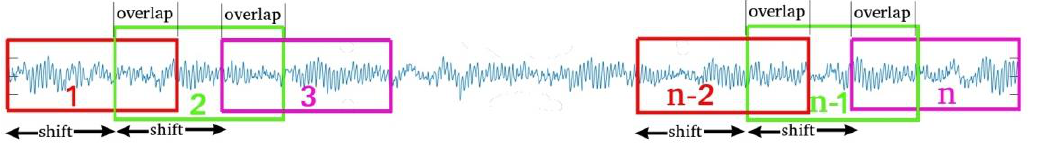
Figure 8. Schematic diagram of the data augmentation.